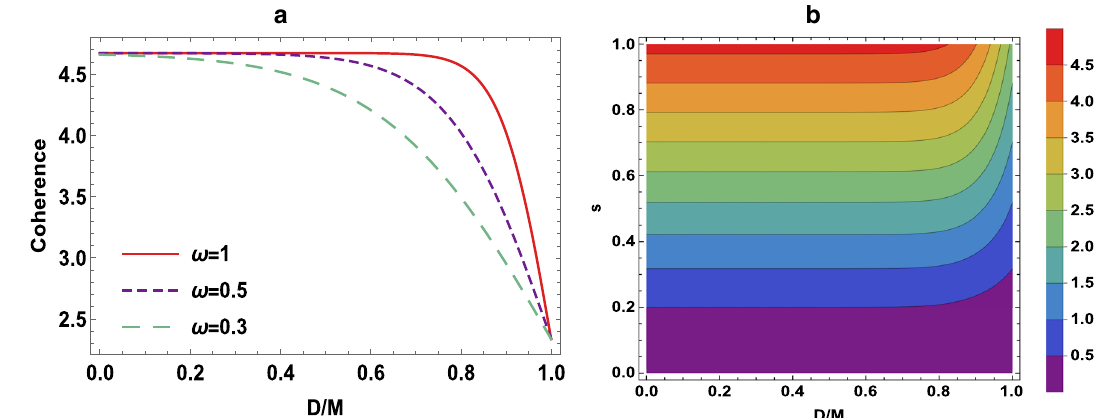
Fig. 2 a Plots of the quantum coherence between Alice and Bob as a function of the ratio D / M between the dilaton charge and the mass of the black hole. The initial squeezing parameter is fixed as s = 1 and the frequency of the field are ω = 1 (red line), ω = 0 . 5 (purple